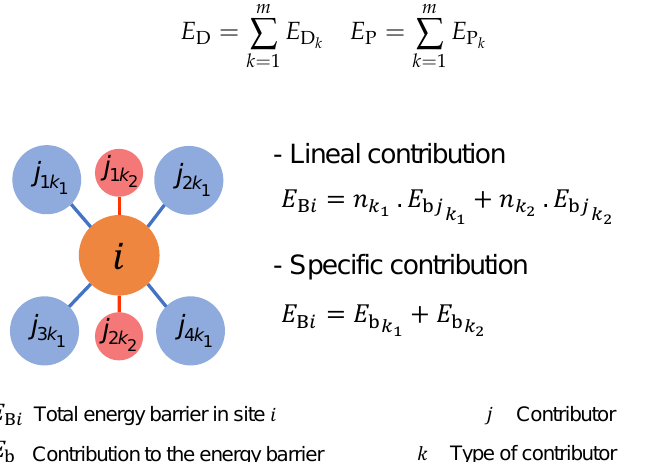
Figure 2. Example of lineal or specific definition of energy barrier available in KIMERA. The orange sphere i represents the particle under consideration, the blue and red particles j represent particles bonded to the i of two different types. The sub-indexes of these j particles indicate their type k 1 and k 2 , and their number, 4 and 2 for k 1 and k 2